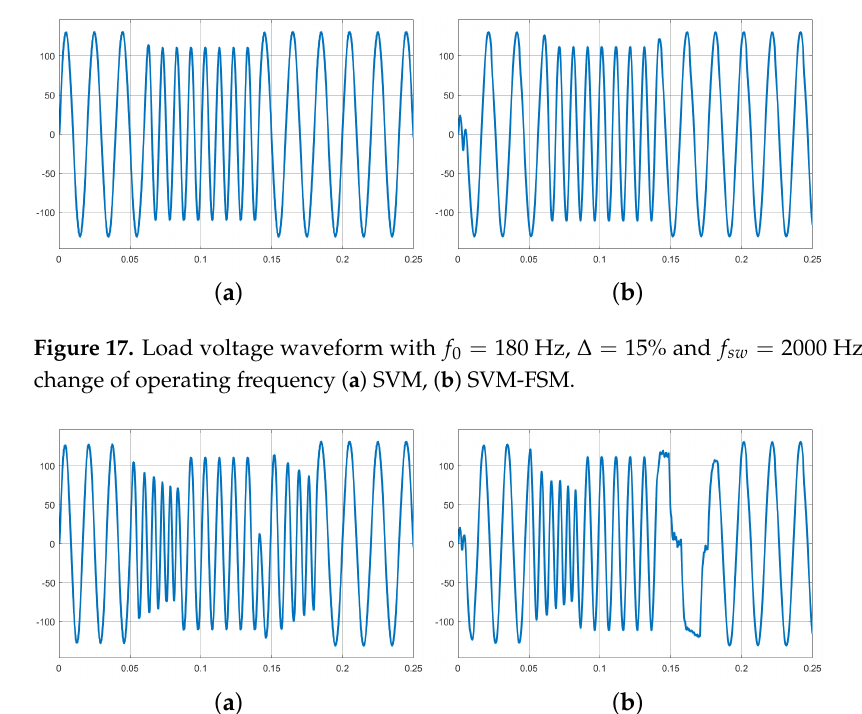
Figure 16. Load voltage waveform with f 0 = 180 Hz, ∆ = 15% and f sw = 2000 Hz, Variable reference voltage ( a ) SVM, ( b ) SVM-FSM.